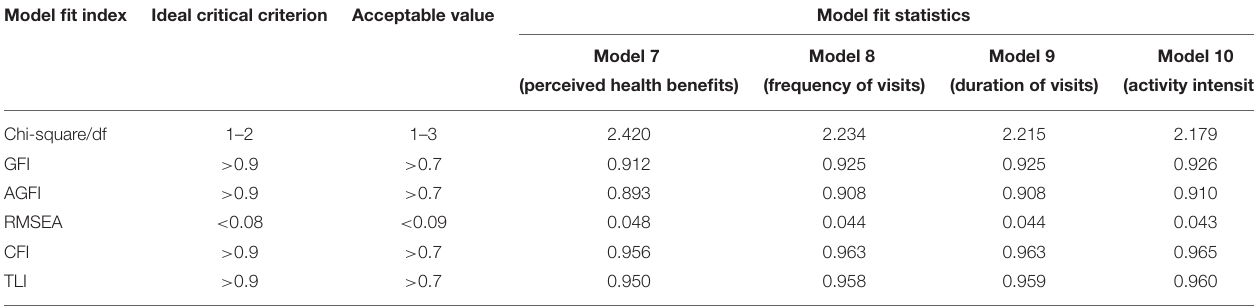
TABLE 6 | Model fit indexes.